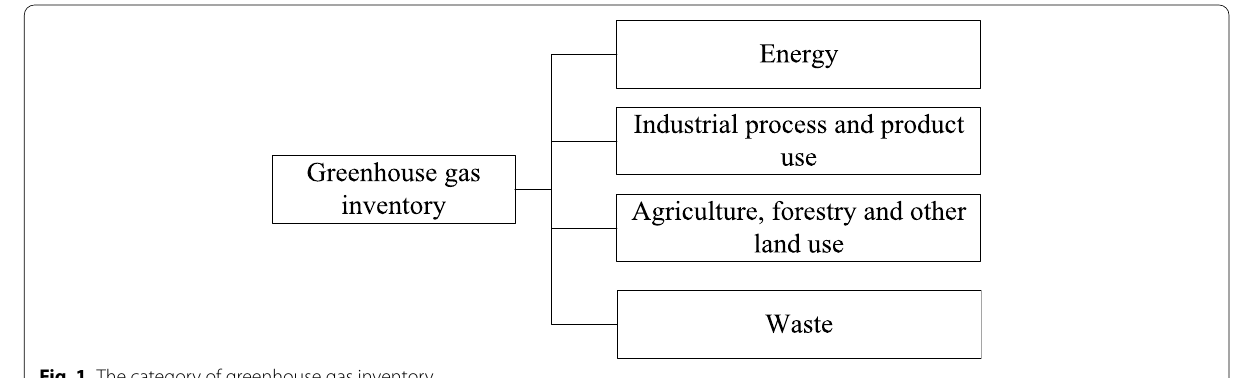
Fig. 1 The category of greenhouse gas inventory